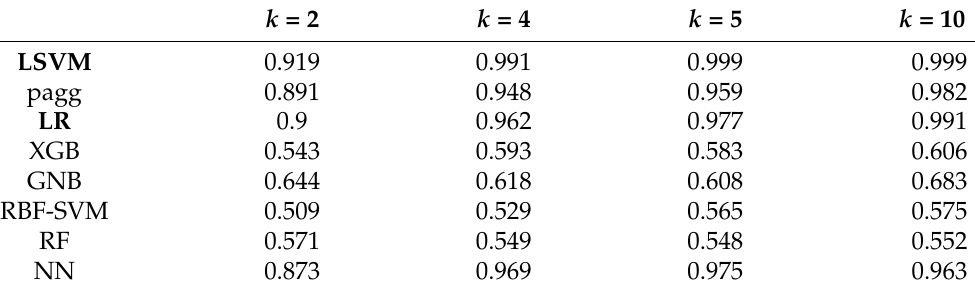
Table 4. Calculated area under the curve for each classifier across the k-folds, with k = 2, 4, 5, 10. k =